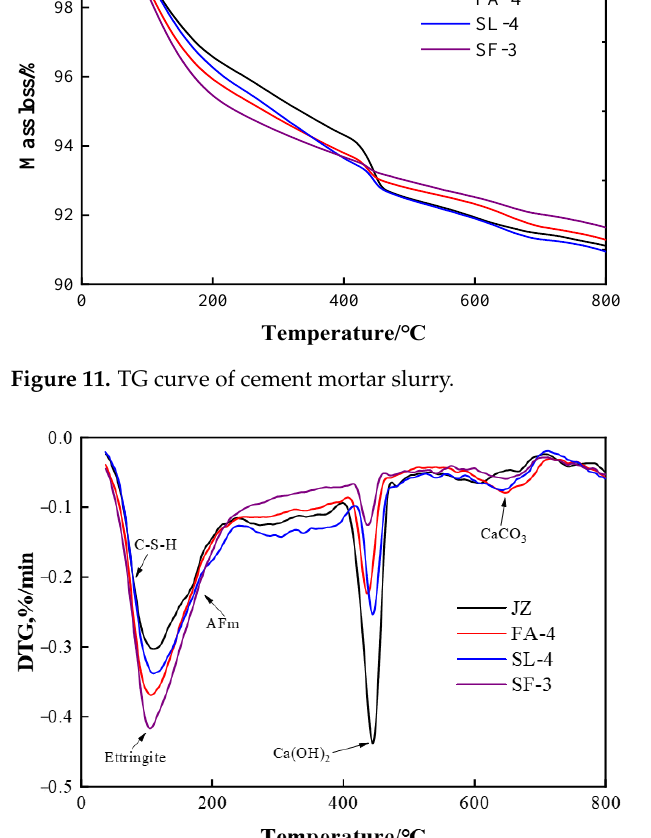
Figure 13. Content of chemically combined water and Ca(OH) 2 in cement mortar slurry.